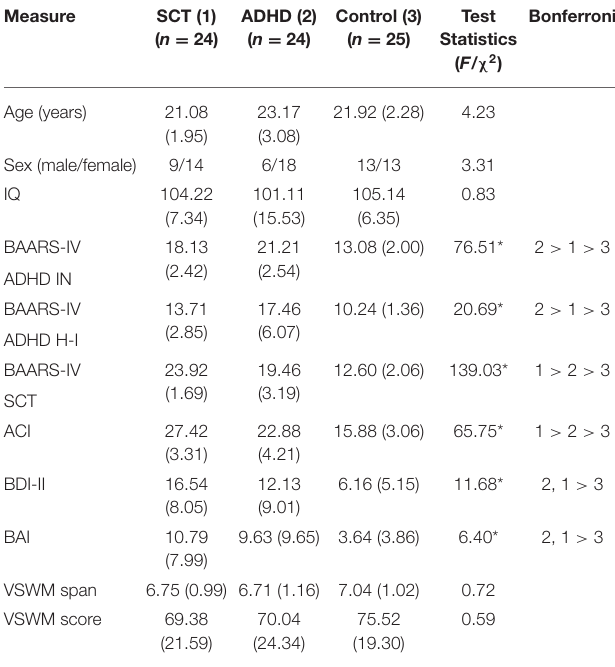
TABLE 1 | Demographic and clinical characteristic for each group.